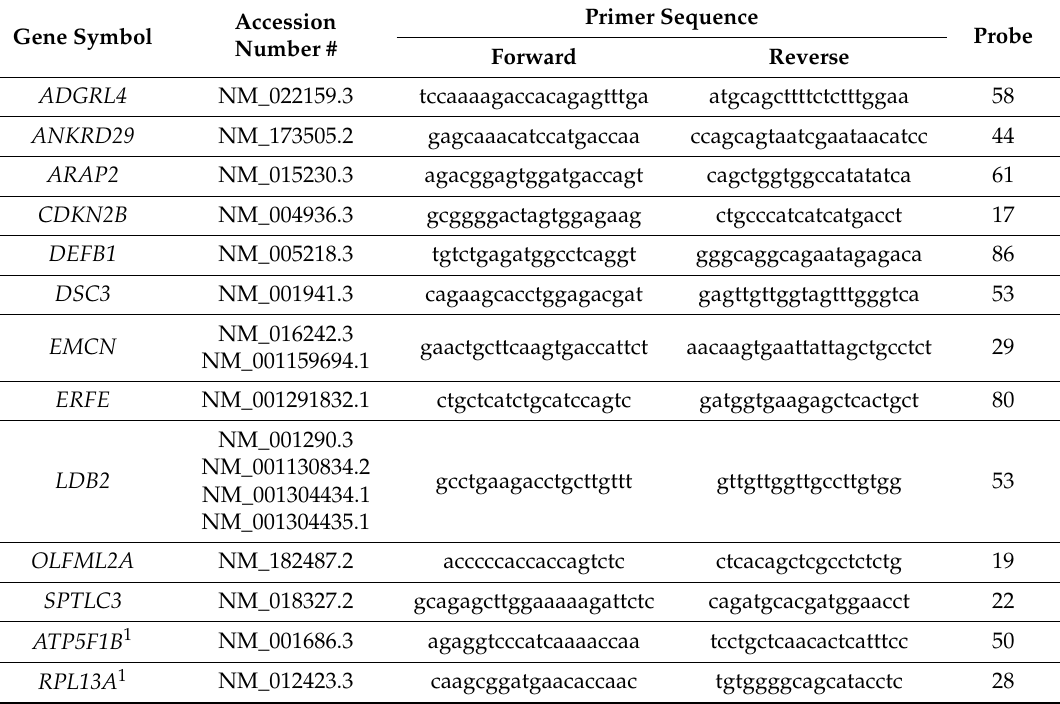
Table 6. Primer and probes used in quantitative gene expression